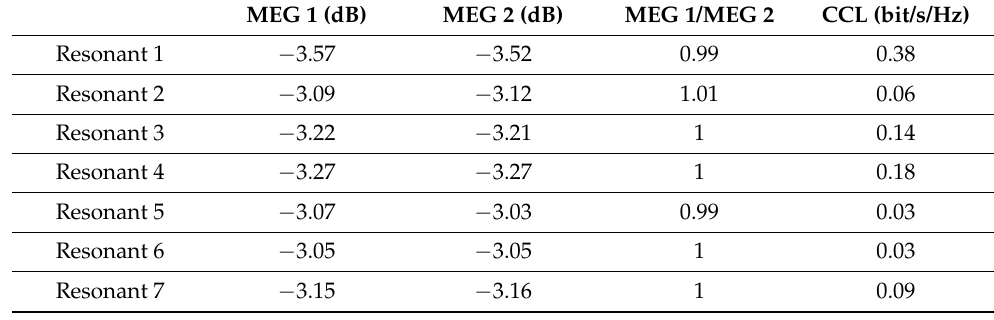
Table 5. Proposed MIMO antenna characteristics at the resonant frequencies.